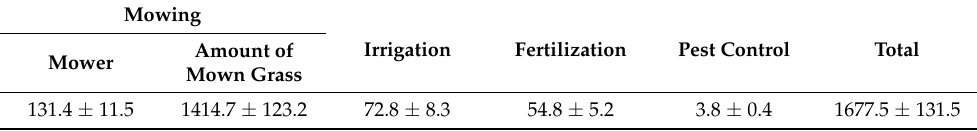
Table 9. Carbon emissions per unit area by vegetation management over the life cycle (g/m 2 ).